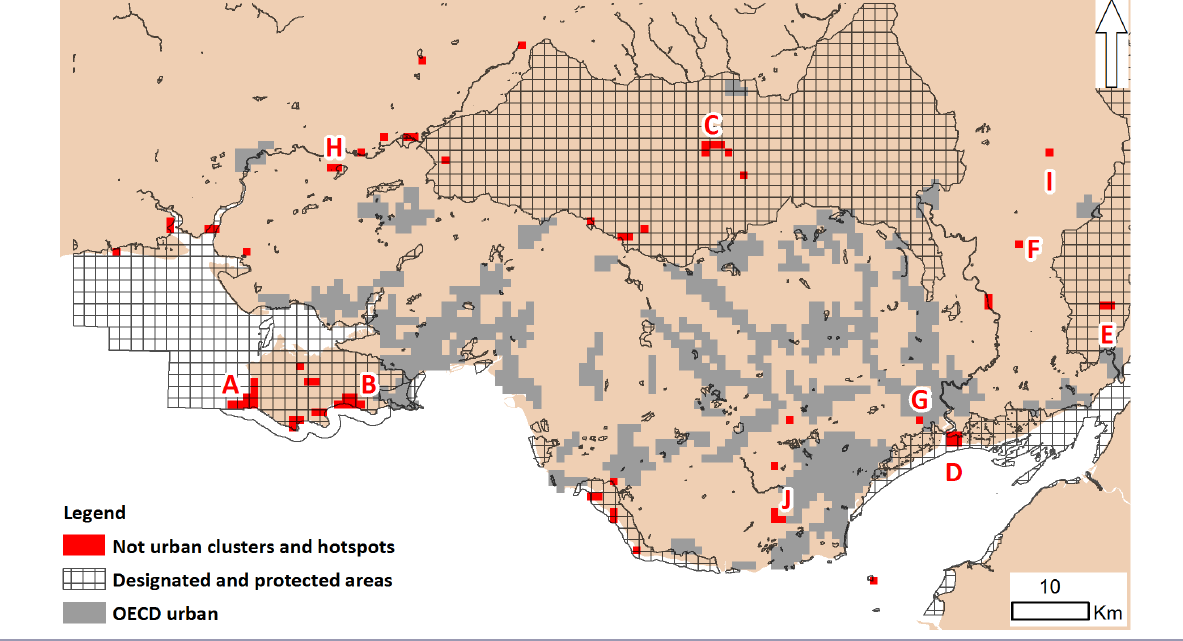
Fig. 6. Clusters and hotspots, as identified by Moran’s I local indicator of spatial association (LISA). Letters indicate clusters of grid units discussed in the